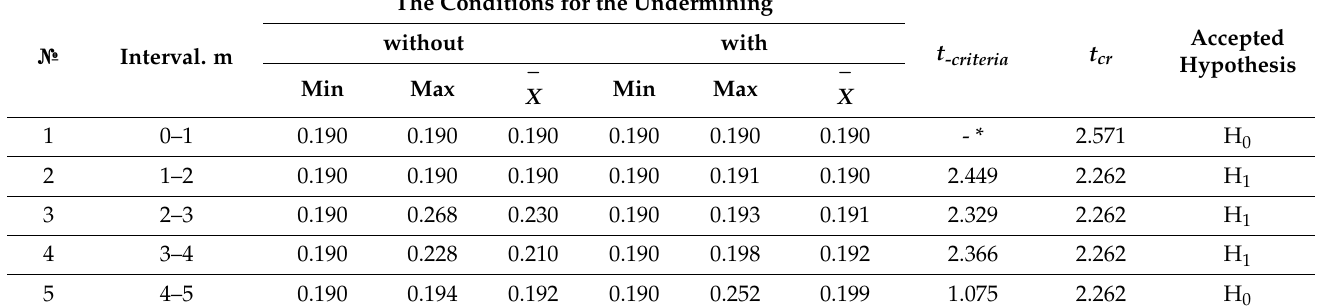
Table 12. The results of the statistical analysis of the experimental studies of the free gas pressure of the camera